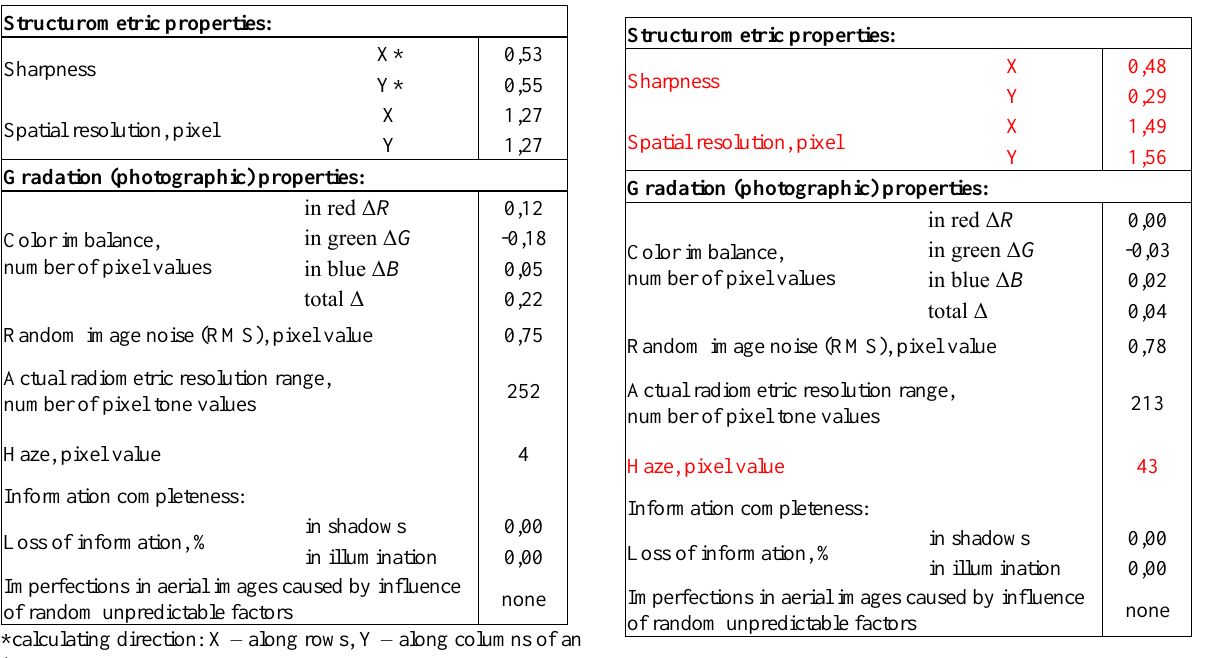
Table 1. The quality assessment results of image with good visual quality, shown in Figure 17